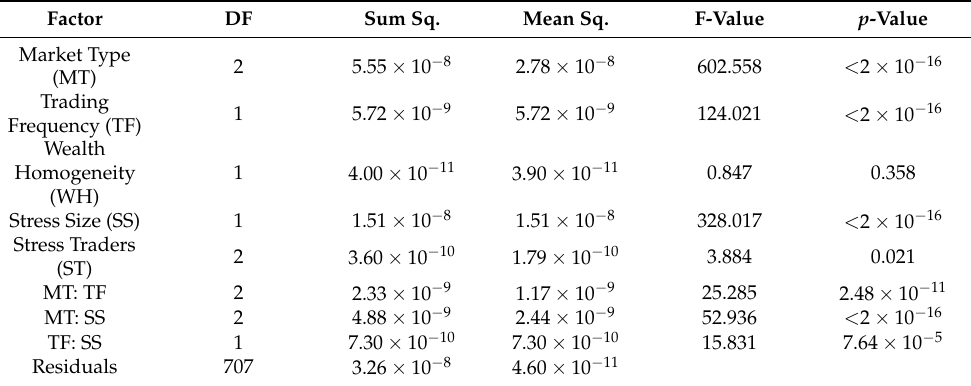
Table 7. Analysis of variance on the slope of the market drawdown in our simulated stress events. Factor DF Sum Sq. Mean